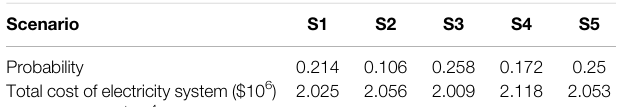
TABLE 3 | Scheduling results of different